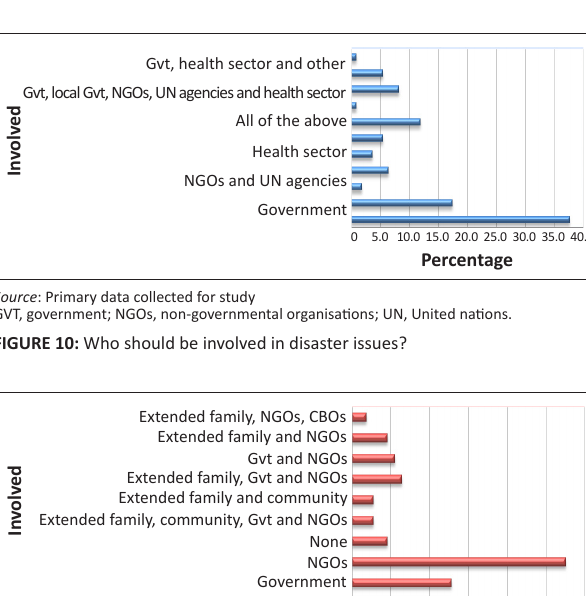
FIGURE 9: Reasons for mode of involvement in disasters.